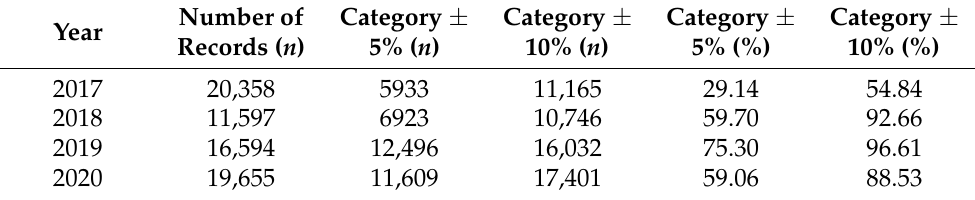
Table 8. Percentage of relative differences between IRMI and NDRE in the individual years